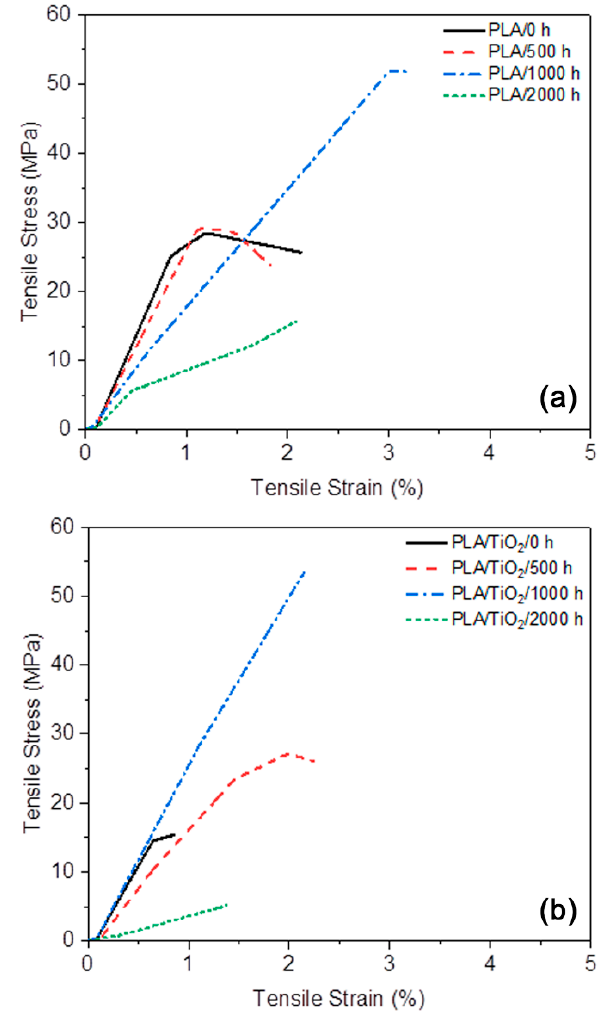
Figure 15. Representative tensile stress–strain curves of ( a ) PLA and ( b ) PLA/TiO 2 after different periods of accelerated weathering.